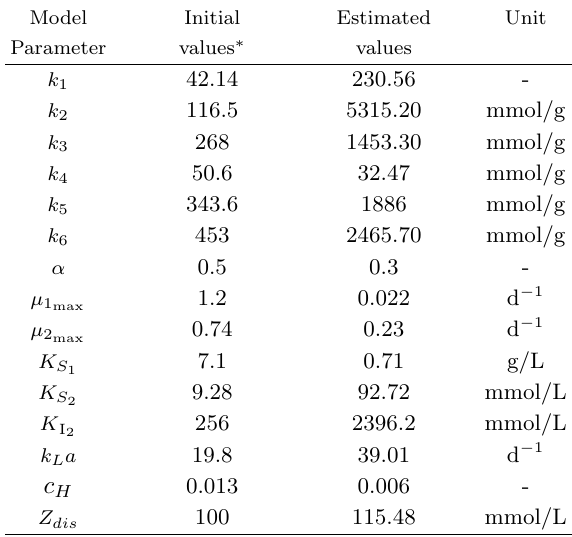
Table 8: The initial values and the estimated model parameter values regarding the experimental data from the VEAS reactor